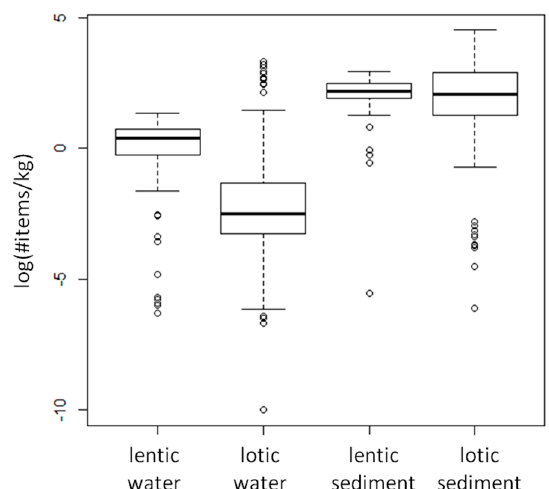
Figure 7. Concentration of microplastics in di ff erent sites: water and sediments of lentic and lotic freshwater.